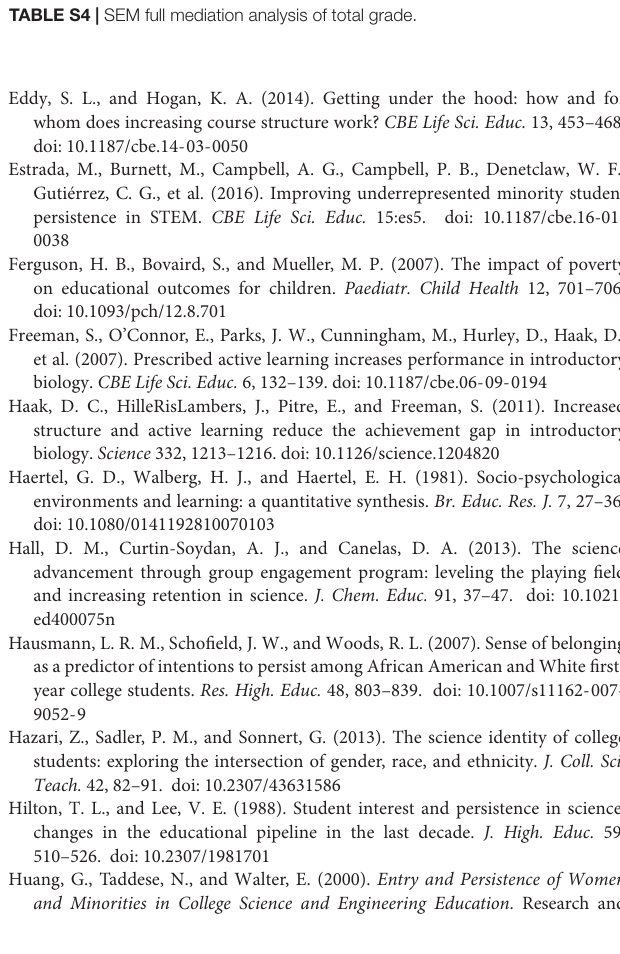
FIGURE S1 | Results from the final five-factor CFA model. TABLE S1 | Social psychological factor loadings. TABLE S2 | Latent social psychological factor correlations. TABLE S3 | SEM full mediation analysis of exam performance. TABLE S4 | SEM full mediation analysis of total